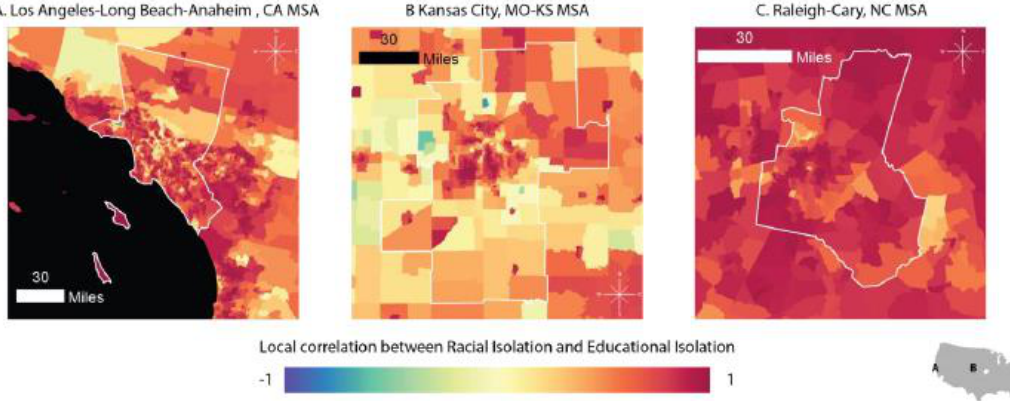
Figure 5. Census-tract level local correlation between racial isolation and educational isolation in three MSAs: Los Angeles – Long Beach – Anaheim (Panel A ); Kansas City (Panel B ); and Raleigh – Cary (Panel C ). Each MSA is projected to the appropriate projected coordinate system for its location in space, specifically: Panel A : NAD 1983 State Plane California V FIPS 0405 Feet; Panel B : North American Datum (NAD) 1983 Universal Transverse Mercator (UTM) Zone 14N; Panel C : NAD 1983 State Plane North Carolina FIPS 3200 Feet.